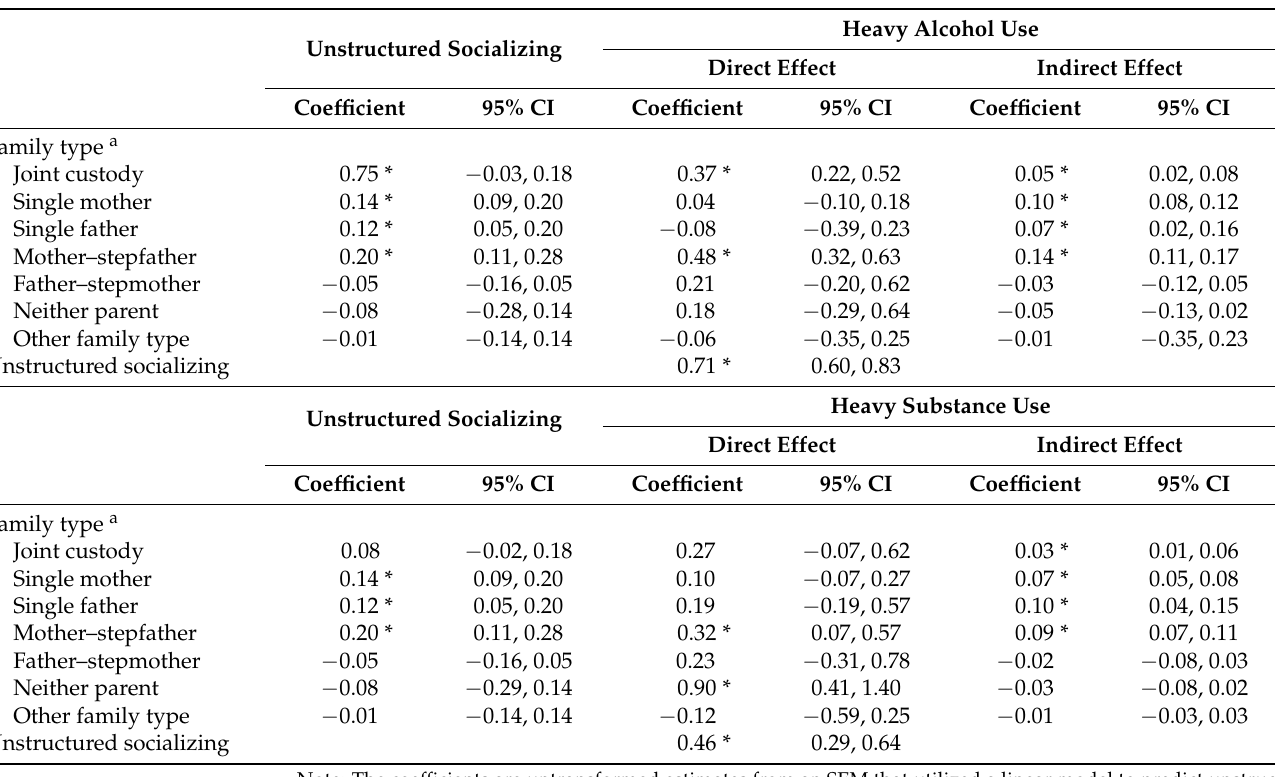
Table 6. Direct and indirect effects via unstructured socializing of family structure on heavy alcohol use and heavy substance use among adolescents, ISRD-2,